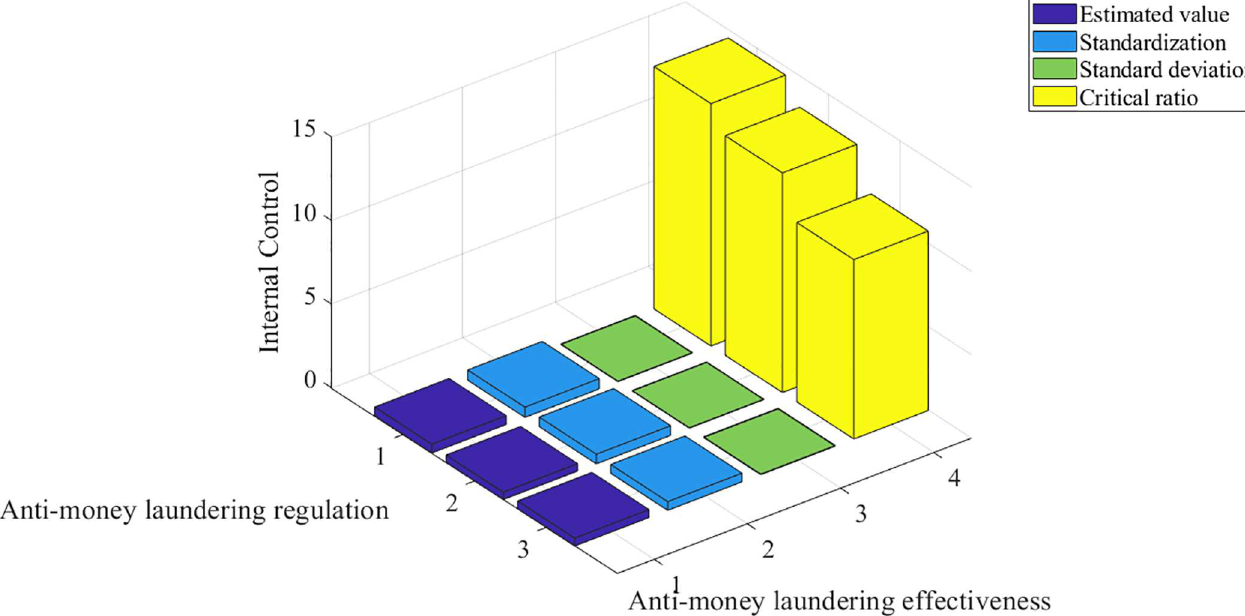
Fig 6. Parameter estimation table for the modified conceptual model of influencing factors on the effectiveness of anti-money laundering regulation.